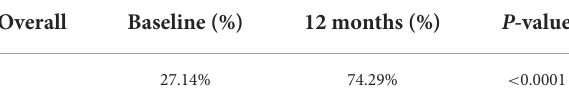
TABLE 13 Percentage of subjects with a null or low-risk consumption in Group 2 subjects who were administered > 80 mg/day at any timepoint.